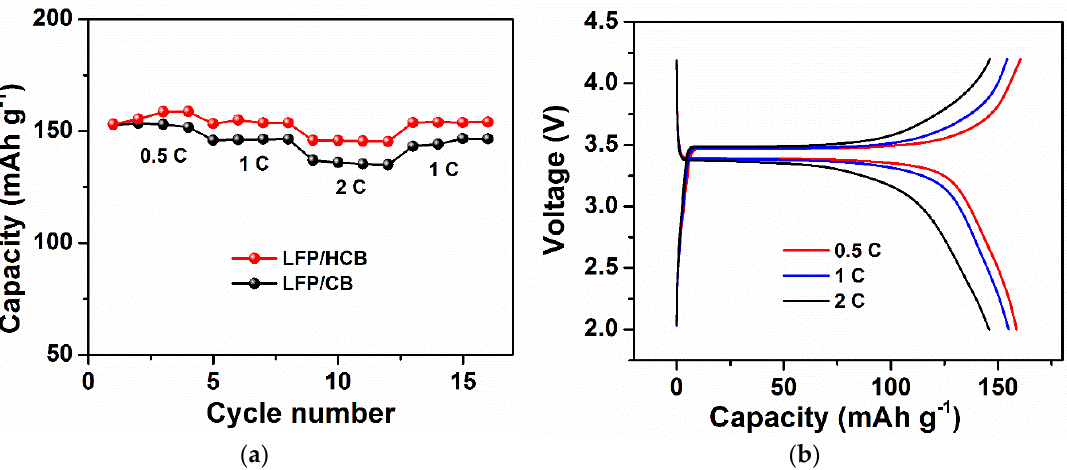
Figure 8. The electrochemical tests of carbon black. ( a ) Cycling stability. ( b ) Galvanostatic charge/discharge curves.